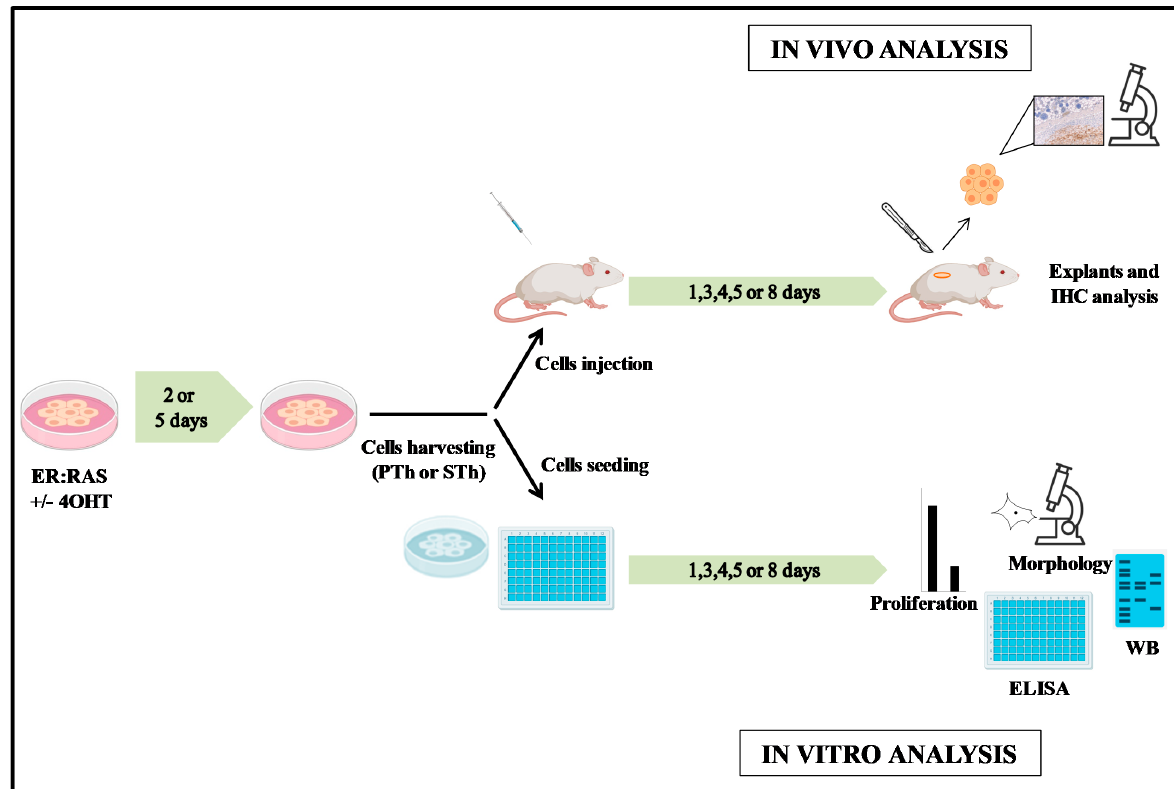
Figure 1. Flowchart of the senescent cells experimental design. 4OHT (Tamoxifen); Th (thyrocytes); PTh (proliferating thyrocytes); STh (senescent thyrocytes); IHC (immunohystochemistry).